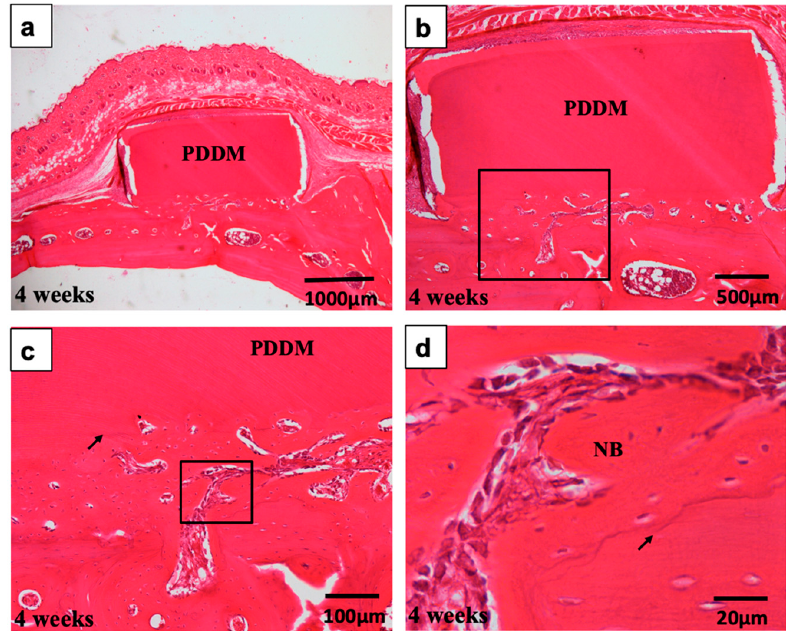
Figure 8. Histological images of scratched skull without periosteum at 4 weeks. ( a ) Acellular PDDM block connected with skull. ( b ) New bone formation widely between PDDM and skull. ( c ) Higher magnification of frame in ( b ). PDDM divided from new bone by the presence of a linear cementum line (arrow) between them. ( d ) Higher magnification of frame in ( c ). New bone with osteoblast-lining divided from skull by cementum line (arrow). PDDM: Partially demineralized dentin matrix.